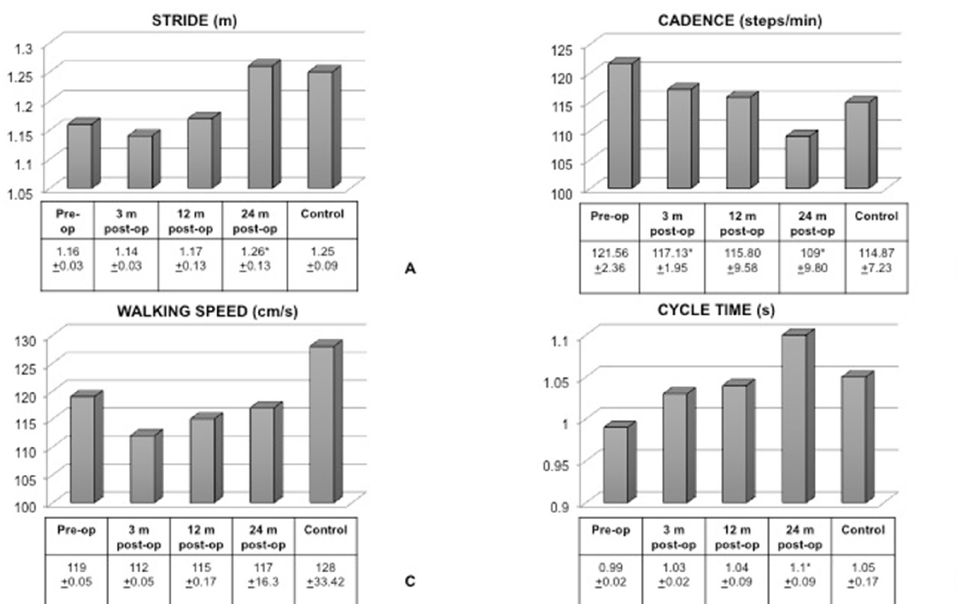
Figure 2. Gait analysis data. Stride (A), cadence (B), walking speed (C), and cycle time (D) were considered in patients before surgery and 3, 12, and 24 months after surgery and compared with the control. A: * indicates p < 0.05 for 24 months post-op vs pre-op. B: * indicates p < 0.05 for 3 and 24 months post-op vs pre-op. D: * indicates p < 0.05 for 24 months post- op vs pre-op.